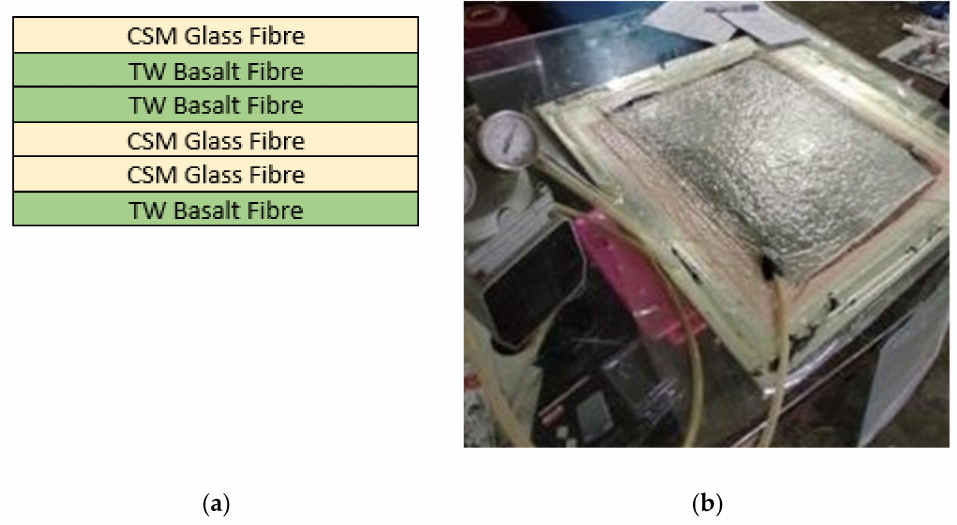
Figure 2. Fabrication setup of WB/GCSM composites: ( a ) fibre sheets arrangement; and ( b ) vacuum bagging